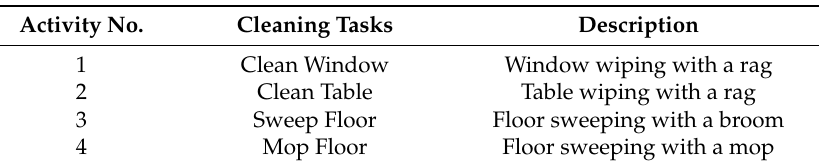
Table 1. The description of the cleaning tasks.